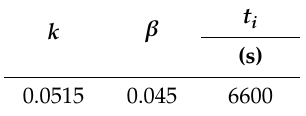
Table 6. Parameters of the relaxation modulus by EPL expression.